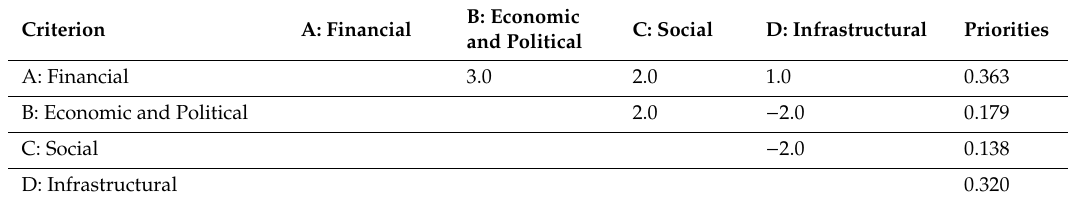
Table 4. Compare the relative importance with respect to the goal: GB market